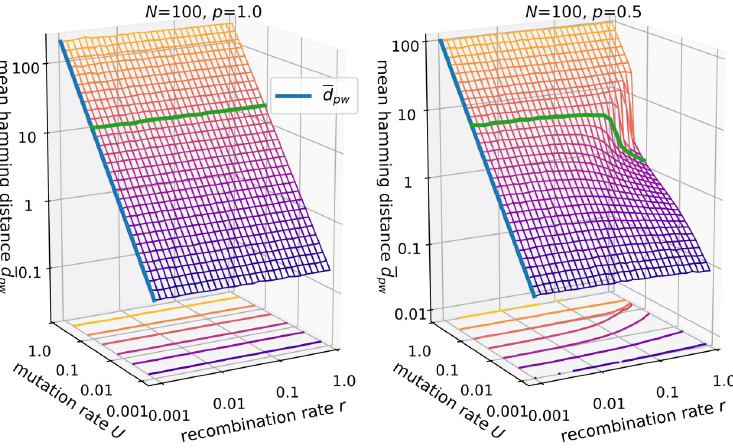
Fig 6. Mean Hamming distance in the ism . Parameters are N = 100 and p = 1.0 (left panel) vs. p = 0.5 (right panel). The blue lines shows Eq 17. The green line is drawn at U =